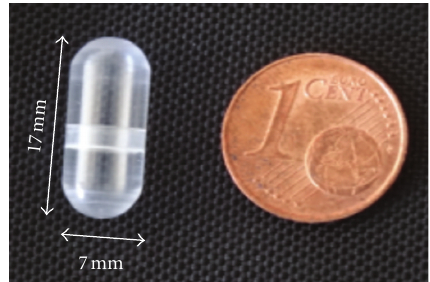
Figure 1: Example of possible